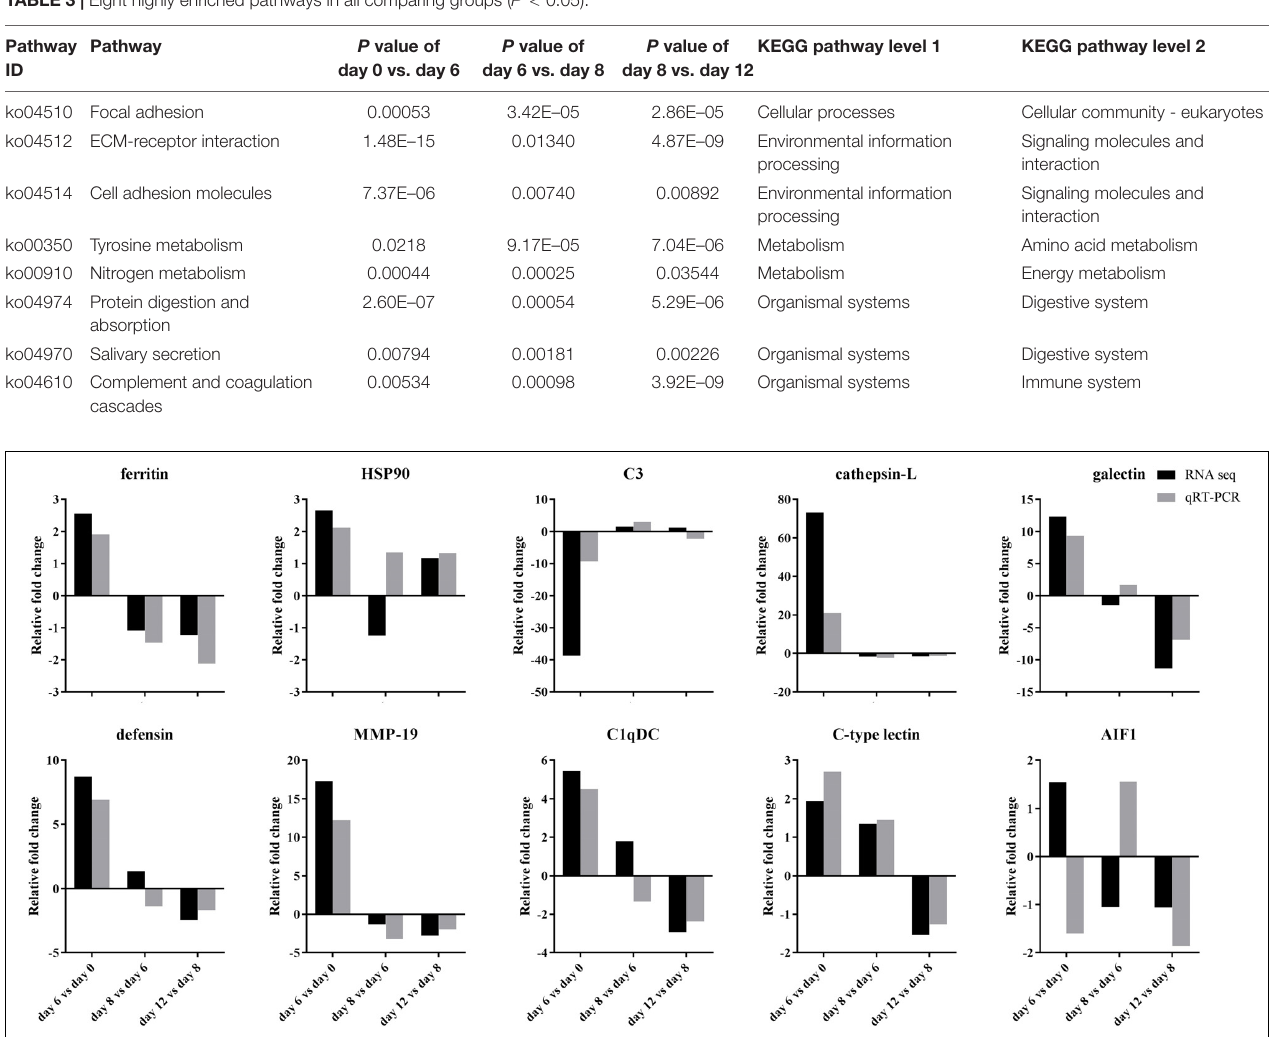
FIGURE 8 | Comparison of fold changes of mRNA expression levels in 10 immune-related unigenes detected by transcriptome sequencing and qRT-PCR after grafting. HSP90: heat shock protein 90, C3: complement complement C3, MMP-19: matrix metalloproteinase-19, C1qDC: C1q domain containing protein, AIF1: allograft inflammatory factor